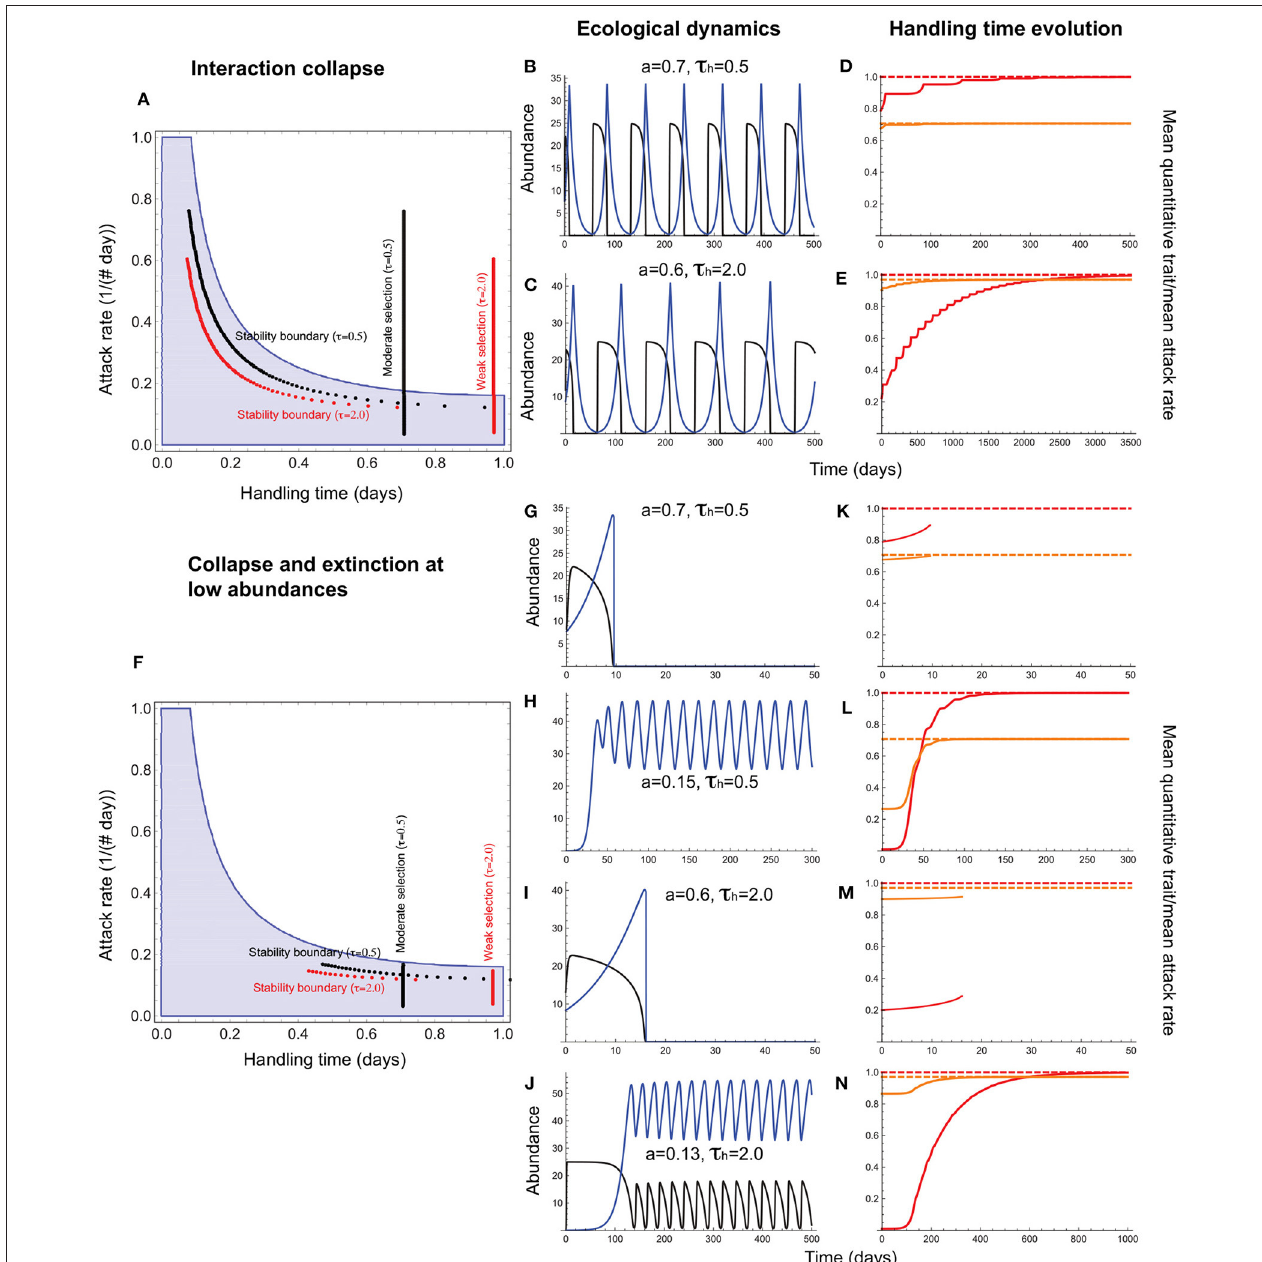
FIGURE 6 | Handling time evolution when it is a resource trait. (A–E) depict outcomes under collapse, and (F–N) , collapse combined with extinction at low abundances. In (A,F) , the red and black vertical lines depict the attack rate-handling combinations that evolve in the model for weak ( τ h 2.0) and moderate = ( τ h 0.5) selection. The red and black curves represent the corresponding stability boundary calculated using these evolved combinations. The blue shaded region = depicts the attack rate-handling time combinations that yield a stable point equilibrium in the absence of evolution. (B,C,G–J) depict resource (black) and consumer ητ h h ( θ h ) , dashed orange line), the quantitative trait mean ( y , (blue) abundances and (D–E,K–N) , the mean handling time [ h ( y ), orange], its expected optimum ( √ σ h 2 = 2 + τ h h ( θ h )), albeit with resource abundances red), and its expected optimum ( θ h 1.0; dashed red line). (B–E) show that the handling time can evolve toward its optimum ( b = reaching extremely low levels at frequent intervals. (G–J) show that such interactions are susceptible to extinction at low abundances that curtails trait evolution. It is b only when the attack rate is sufficiently low that the minimum resource abundance exceeds the levels that predispose it to extinction, and the mean handling time h ( θ h )) (K–N) . Other parameter values are: r evolves to its optimum ( 5.0, q 0.04, e 0.2, d 0.1, σ h = = = = = b